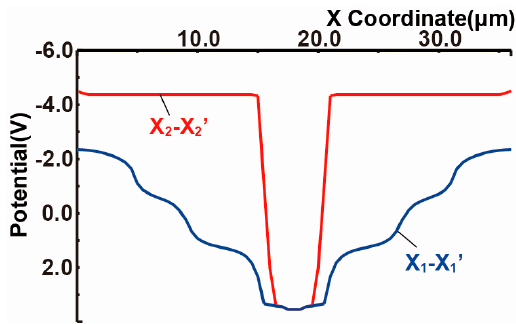
Figure 6. Simulated Horizontal Potential Profiles.